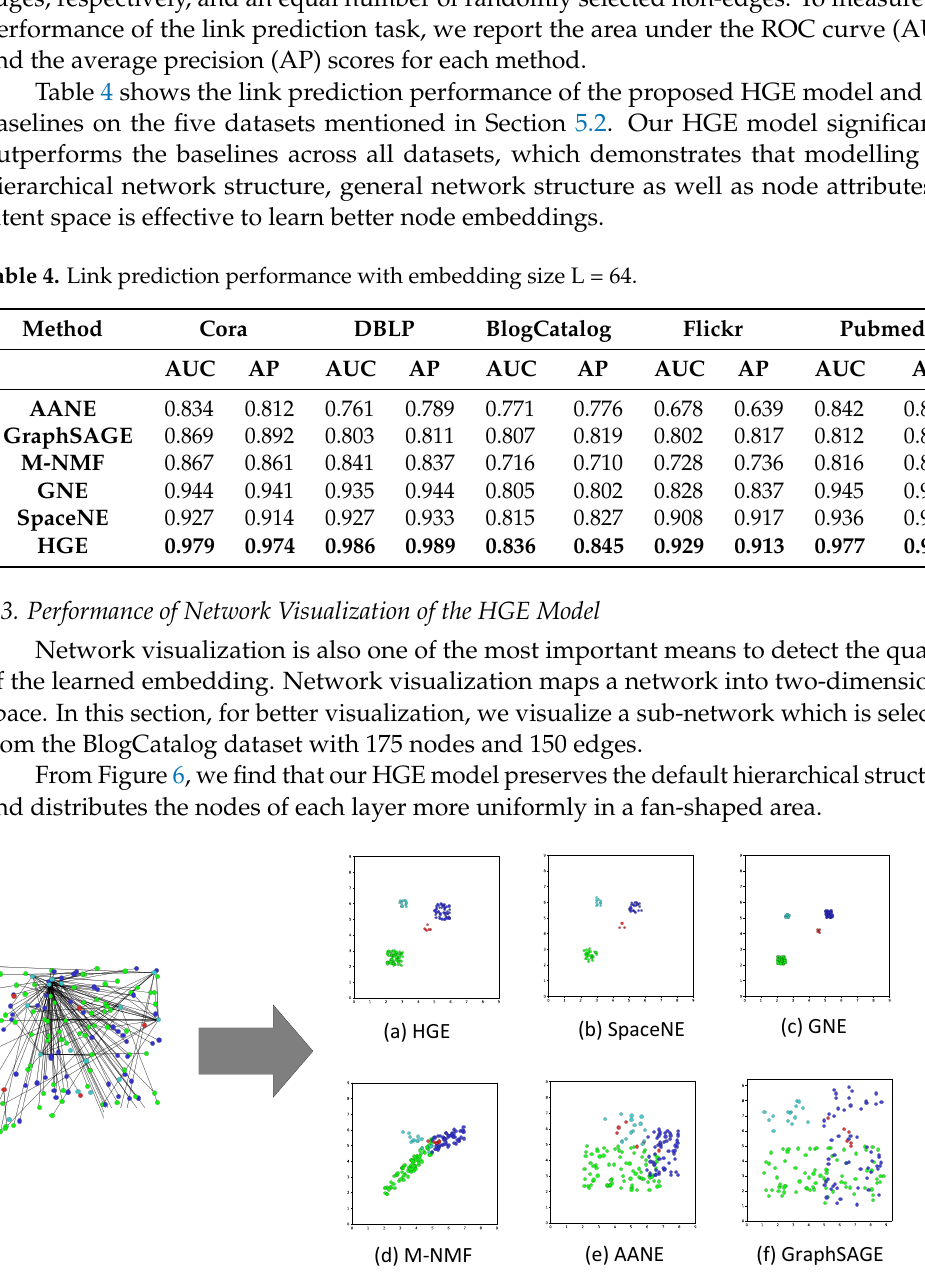
Figure 6. The experimental results of network visualization in two-dimensional